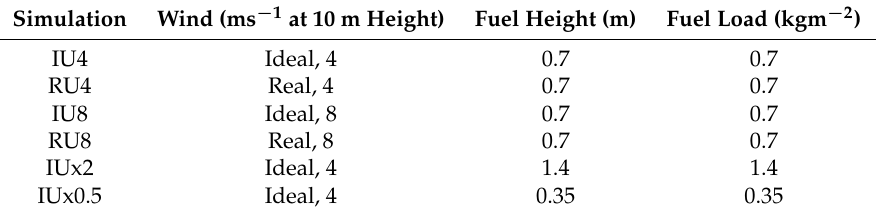
Figure 2. Fire spread and fuel consumption for the idealistic wind case ( left ) and the realistic wind field ( right ) 300 s after ignition. The data were collected on a planar test area (vertical plane 80 m wide in crosswind ( y ) direction and 9 m tall located 300 m downwind ( x ) of the upwind boundary) and all quantities of interest were recorded (marked on figure). For tower and trough behavior, 4 points each were selected at a line on this plane at 1.5 m height, just above the fuel bed. This line was centered in the cross-stream (or y ) direction. The locations of the towers and troughs are marked on the figures with markers—red for towers and blue for troughs. The third panel shows all idealized and realistic wind profiles. Table 1. Experimental design